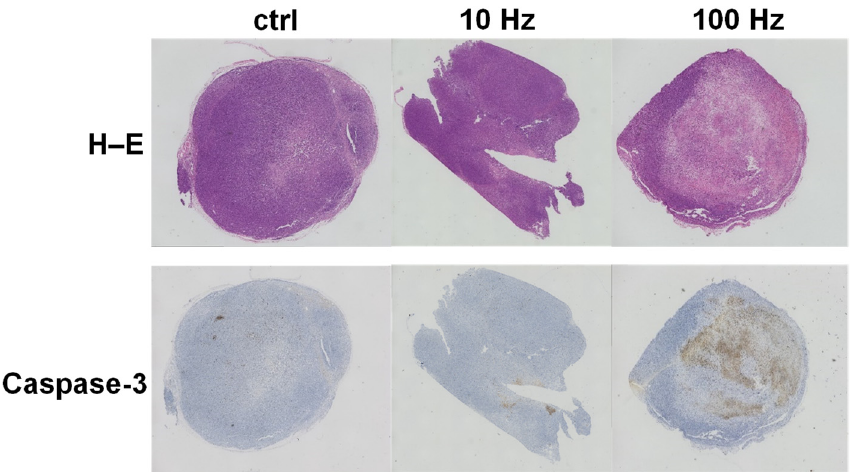
Figure 7. Comparison of H–E staining results and immunohistochemical staining results with anti- cleaved Caspase-3 antibody. We compared the results of H–E staining and immunohistochemical staining with anti-cleaved Caspase-3 antibody performed on post-treatment tumors removed from TRAMP-C2 mice. The photographs show the result of staining of the same individual. The necrotic part and the cleaved Caspase-3 positive part are almost the same, showing that apoptosis induction caused necrosis and suppressed tumor growth.